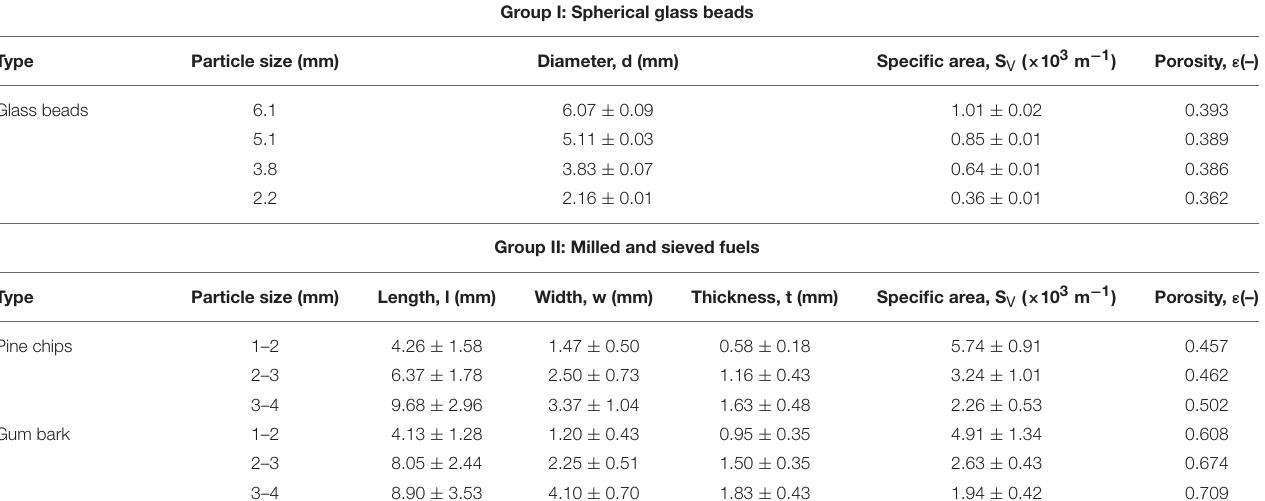
Group I: Spherical glass